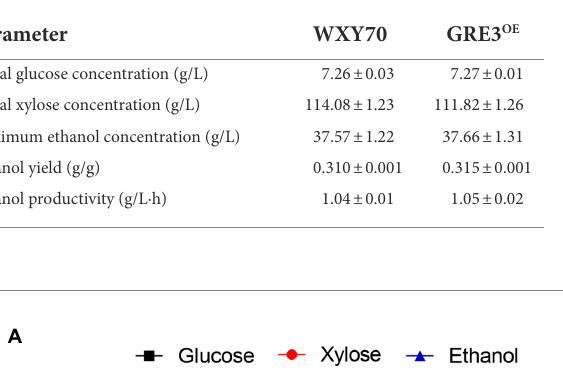
TABLE 4 Comparison of fermentation profile in xylose mother liquor hydrolysate fermentation between WXY70 and GRE3 OE of the 48 h.